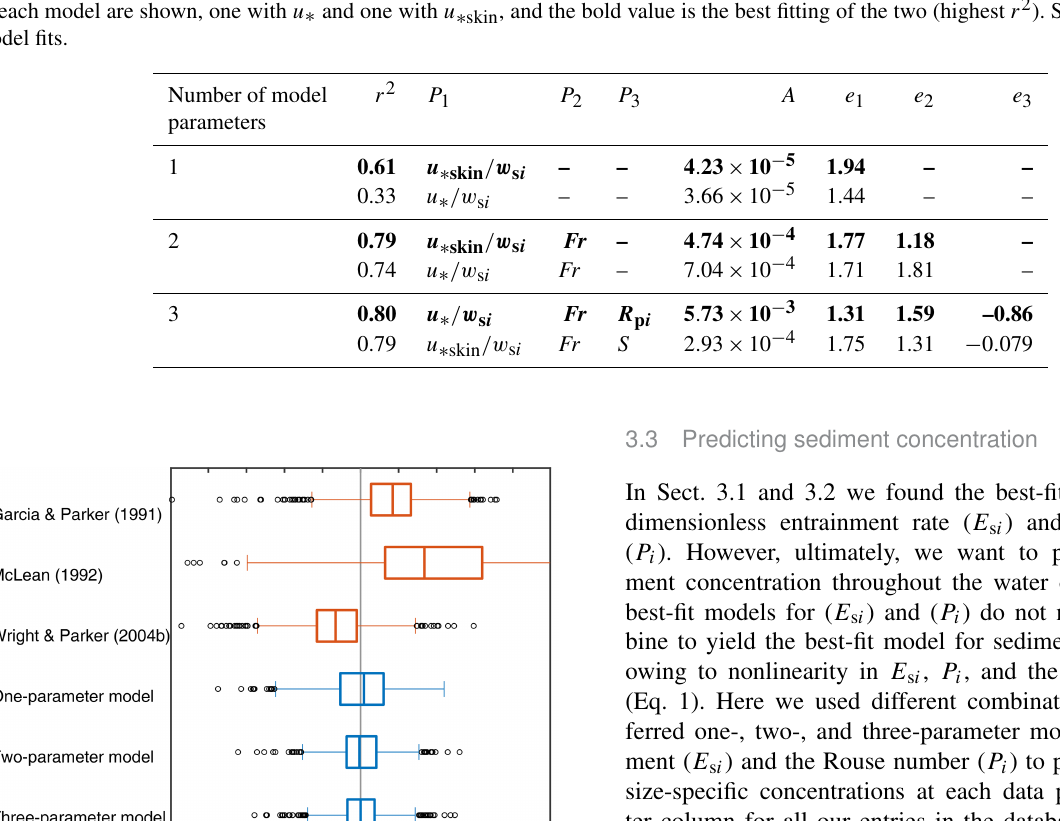
P e 2 P e 3 . The two best-fitting versions 1 2 3